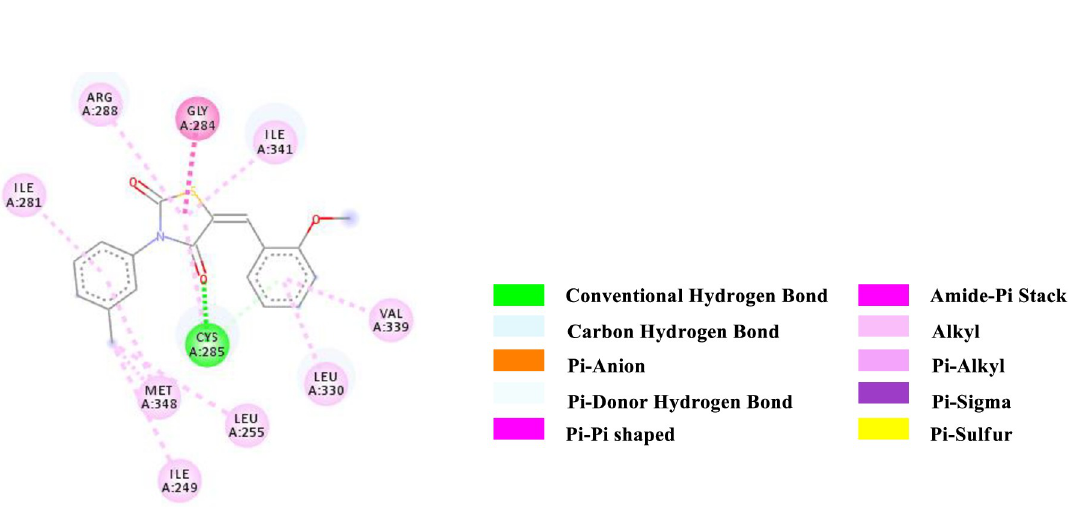
PLOS ONE | https://doi.org/10.1371/journal.pone.0247619 March 4,